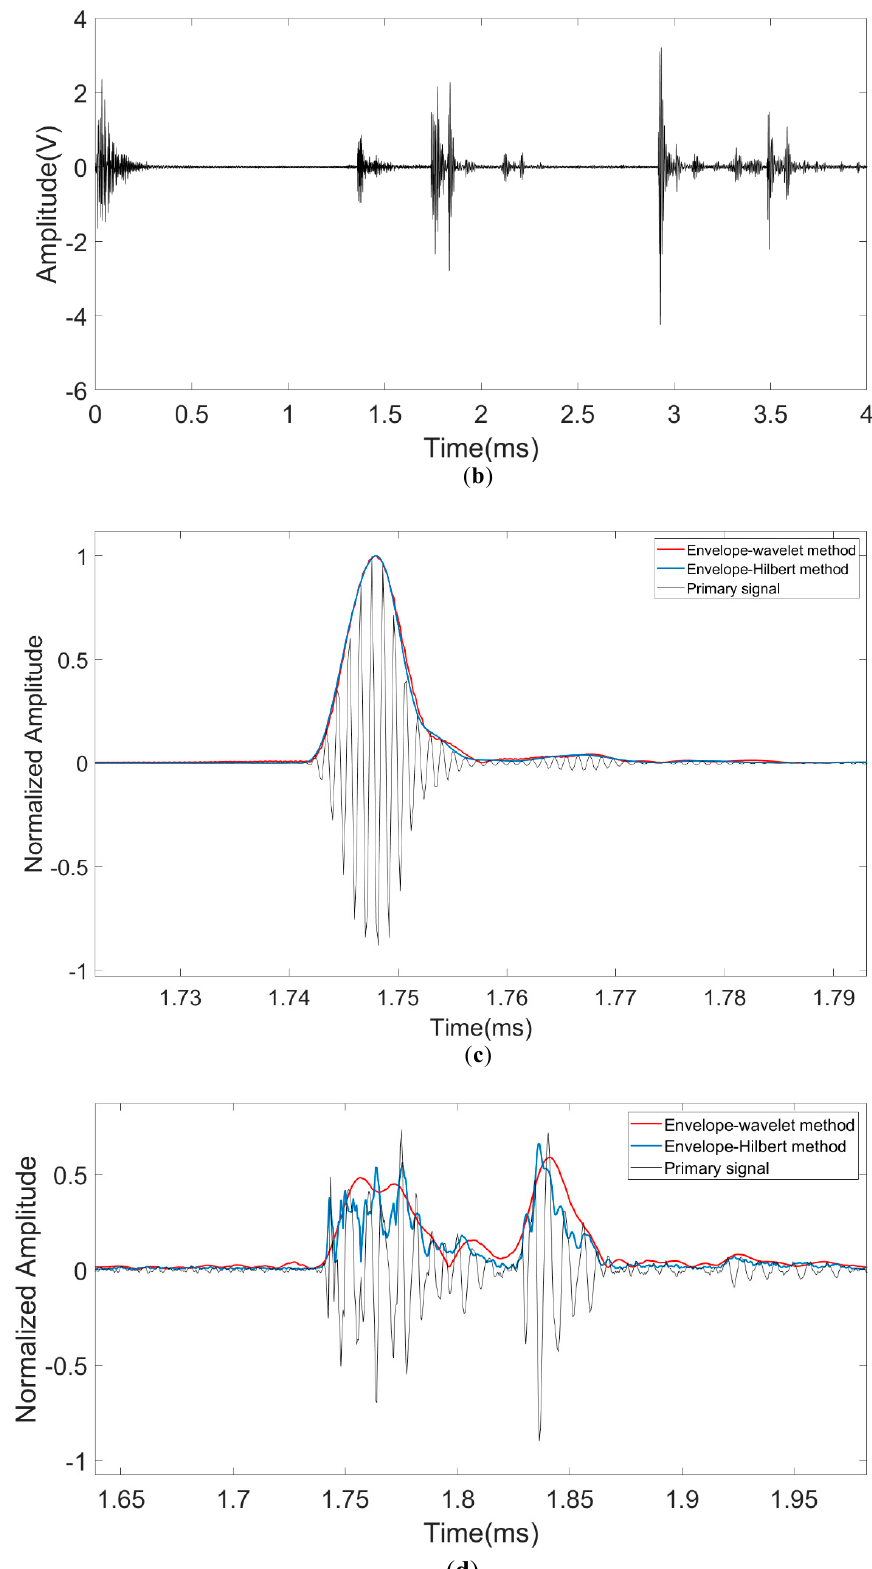
Figure 5. The dual-channel signal of 100th record and the comparison of di ff erent envelope extraction methods. ( a ) The primary signal; ( b ) The secondary signal; ( c ) The comparison of the primary channel; ( d ) The comparison of the secondary